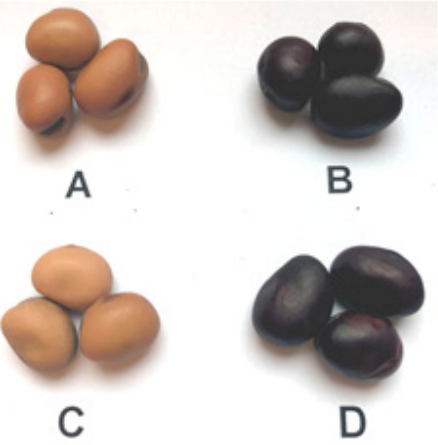
Figure 1. General view of stored seeds: ( A )—Nadwi´sla´nski seeds storage at − 14 ◦ C, ( B )—Nadwi´sla´nski seeds storage at + 20 ◦ C, ( C )—Dino seeds storage at − 14 ◦ C, ( D )—Dino seeds storage at + 20 ◦ C. Figure 1. G eneral view of stored seeds: ( A )—Nadwi ś la ń ski seeds storage at − 14 °C, No clear structural di ff erences between testa of various seeds were visible in SEM images, however, ( B )—Nadwi ś la ń ski seeds storage at + 20 °C, ( C )—Dino seeds storage at − 14 °C, ( D )—Dino seeds small di ff erences in hilum width were noted. The hilum in seeds stored at low temperature was wider storage at + 20 °C. by 10 µ m, compared to seeds stored at 20C (Figure